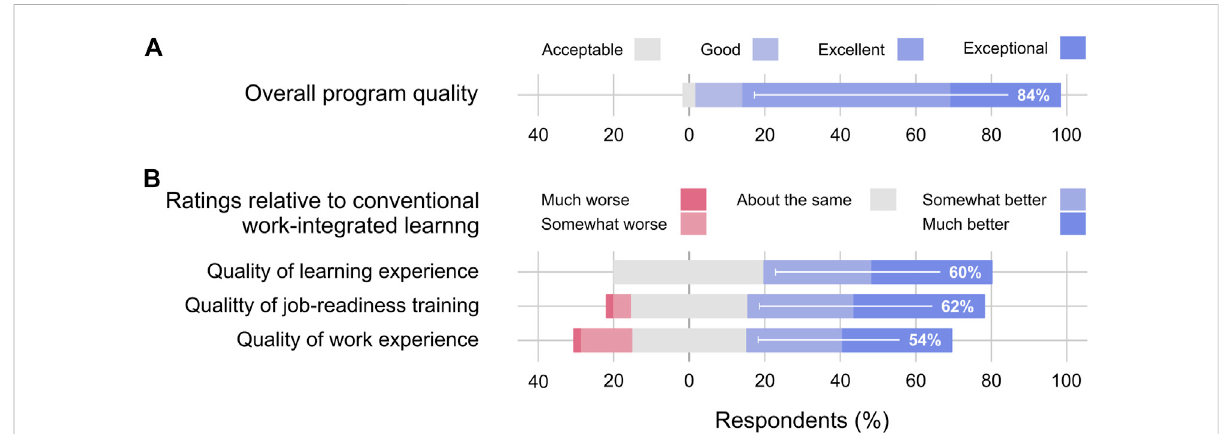
FIGURE 4 Program quality. (A) Distribution of responses to the survey question “ How would you rate your overall experience? “ (B) Distribution of ratings comparing the BioExperience to conventional WIL programs. The quality of the work experience refers to the meaningfulness of the work as perceivedbyrespondents.Horizontalbarsincludethepercentageofrespondentsselecting “ Excellent ” or “ Exceptional ” in (A) and “ Somewhatbetter ” or “ Much better ” in (B)